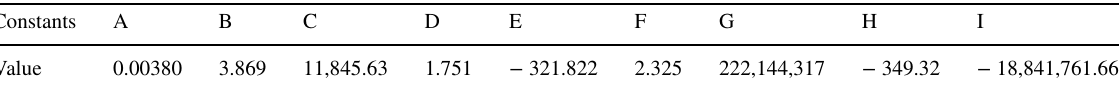
Fig. 17 Peq versus T plot of experimental data (CO 2 hydrates) with “new correla- tion,” AAD = 0.77%